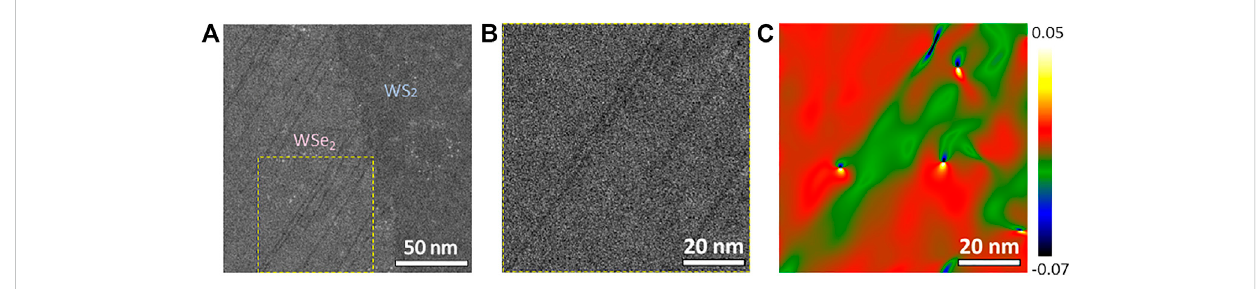
FIGURE 2 Strain analysis of WS 2 2D quantum wells at the interface between WSe 2 and WS 2 . (A) STEM image of WS 2 quantum wells with uniform width at the WSe